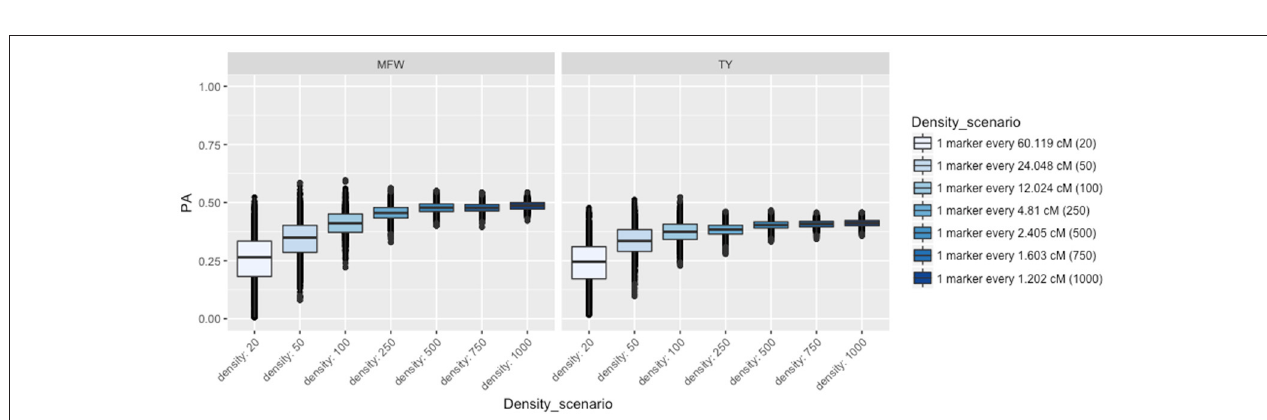
FIGURE 3 | Effect of the marker density on the predictive ability (PA) in GRYG population using across-year estimates adjusted by spatial effects in TY and MFW. One box per trait is displayed (MFW on the left and TY on the right). Within each box a boxplot comparing the different marker densities is shown, from smallest (left) to highest density